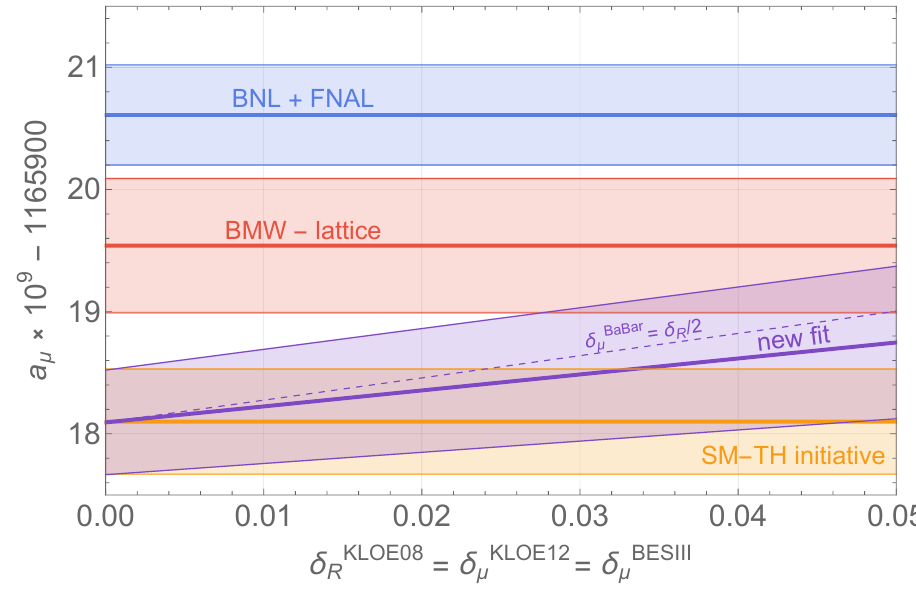
obtained by Figure 1 . Theoretical prediction for a µ based on a data driven global fit to a LO , HVP µ including a NP correction affecting in an equal way e + e − and µ + µ − γ final states (oblique violet band). The thick purple line assumes that the NP does not affect the BaBar result, while the dotted purple line assumes for BaBar an effect half the size than the one in KLOE and BESIII. The blue band corresponds to the combined BNL and FNAL experimental results, the red band to the prediction obtained with the BMW lattice estimate of a LO , HVP [31], and the orange band to the µ one obtained from σ in the absence of NP corrections. The width of the bands represent 1 σ had